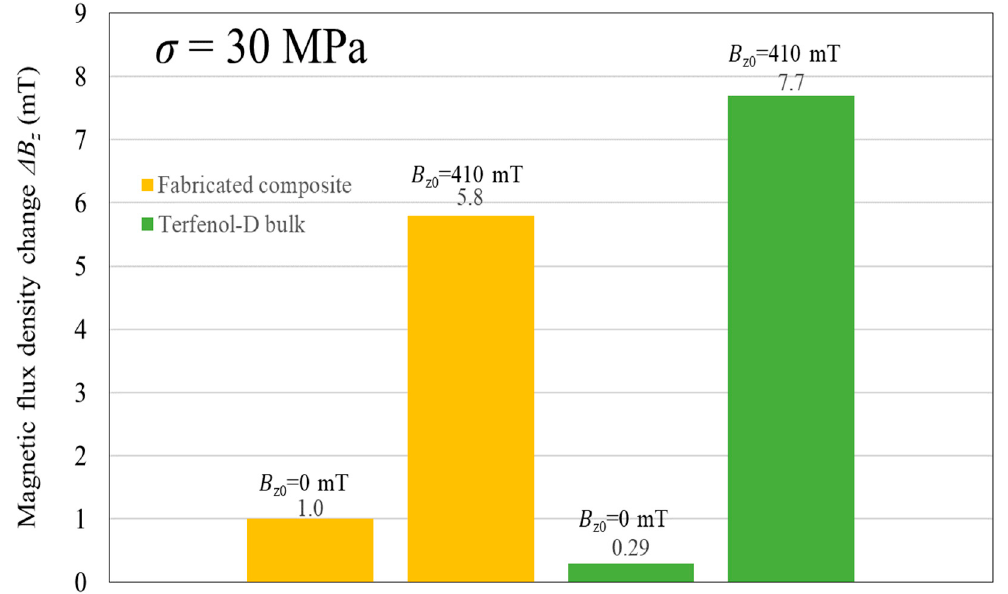
Figure 10. Comparison between fabricated composite and Terfenol-D bulk on the magnetic flux density change at stress σ = 30 MPa.